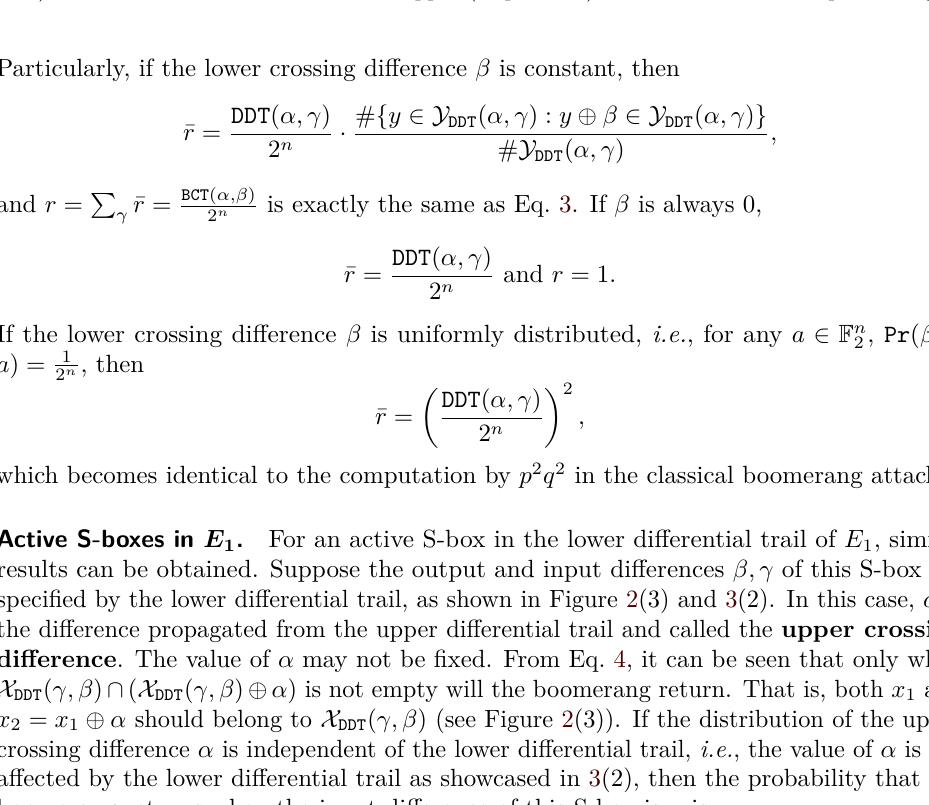
Figure 3: Toy examples of (1) active S-boxes in E 0 , (2) active S-boxes in E 1 and (3) interrelated active S-boxes, where ‘ S ’ denotes an n -bit S-box, ‘ L ’ denotes the linear layer and the red (resp. blue) arrows stand for extensions of the upper (resp. lower) differential trails with probability